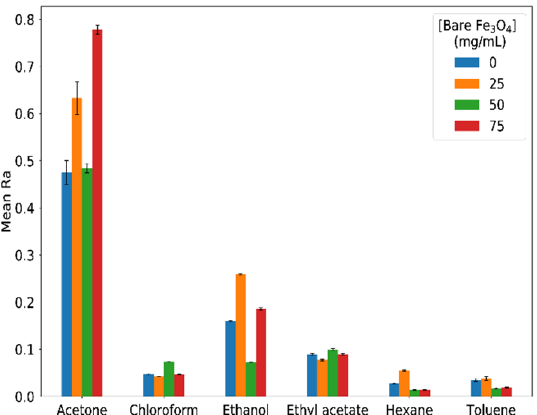
Figure 5. Relative responses of set A sensors upon 10 cycles of exposure to VOCs.